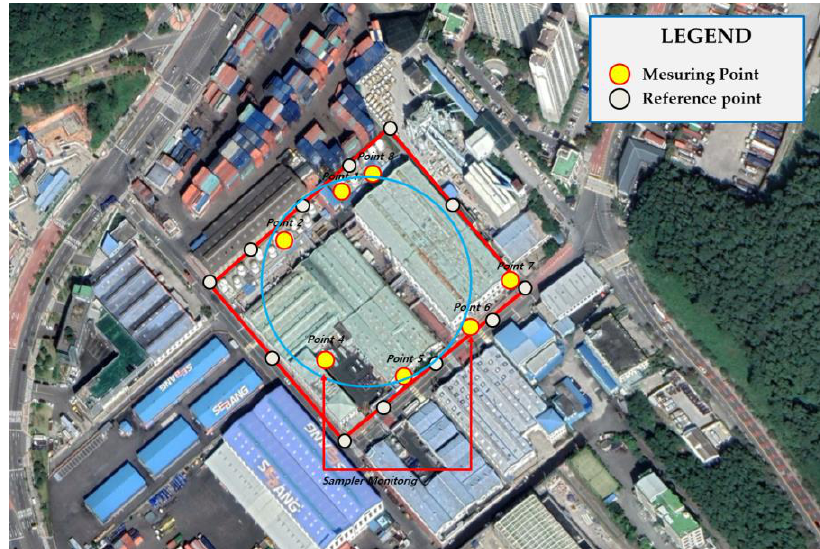
Figure 3. Measurement location of study site A.